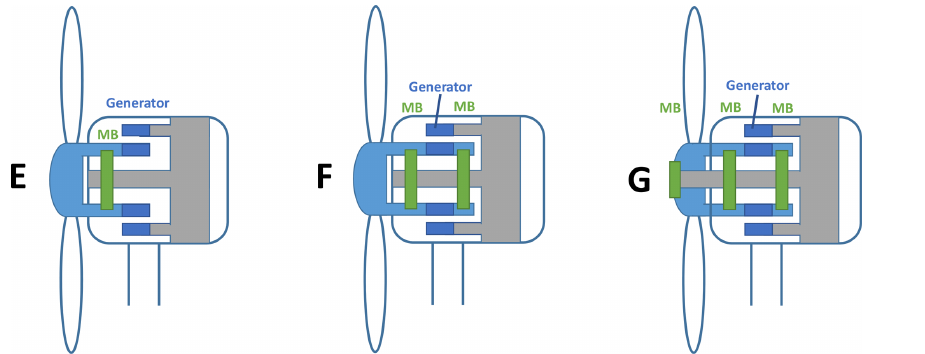
Figure 8. Depictions of some of the existing drivetrain layouts for direct-drive turbines. One example is given for each single-, double- and triple-MB design.